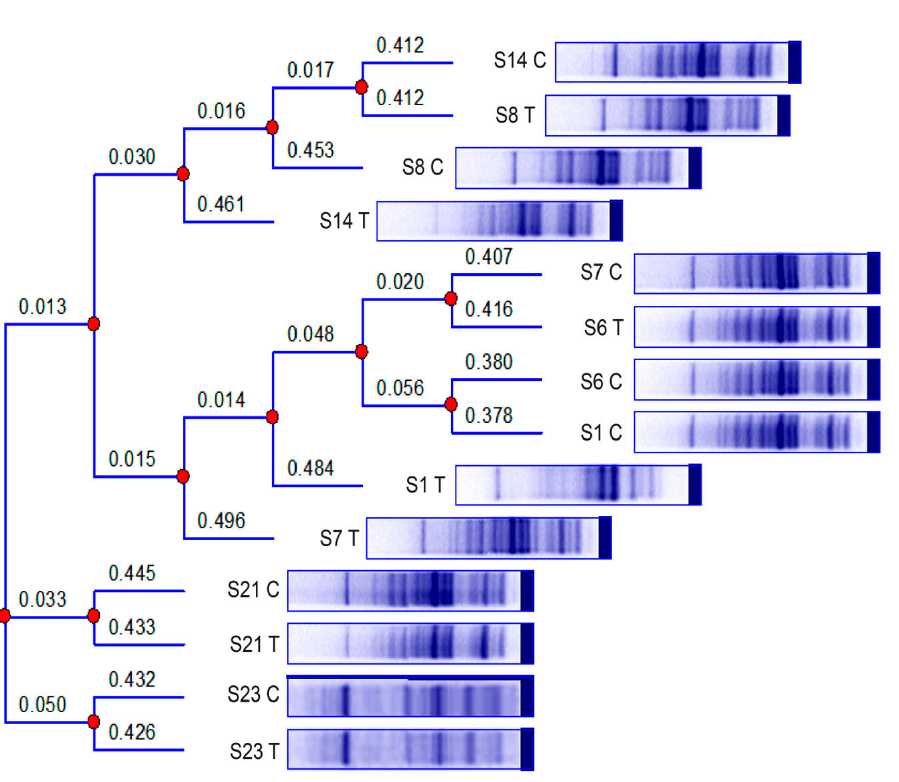
Fig. 5. Phylogenetic tree constructed for the protein profiles of 7 untreated MRSA clinical isolates and those subjected to overnight treatment with 16µg/ml of caspofungin. The numbers above the branch points represent the branch lengths. Codes, “C” and “T” refer to the control and treated samples, respectively, of the protein profiles of S1, S6, S7, S8, S14, S21, and S23 MRSA